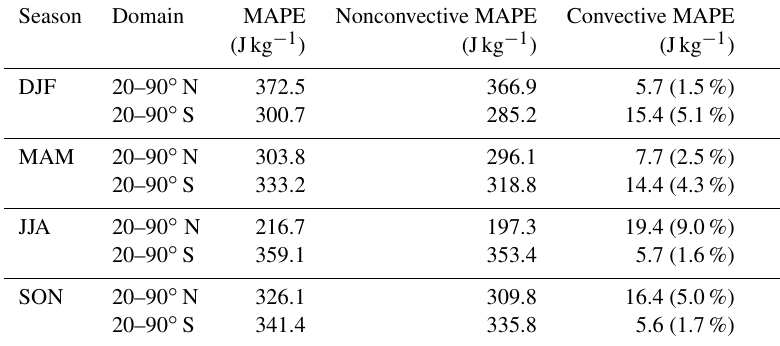
Table 2. Extratropical three-dimensional MAPE, nonconvective MAPE, and convective MAPE in joules per kilogram over 1979–2018. The convective fraction is shown in parentheses as a percentage of full MAPE. Results in this table are based on a lower-resolution horizontal grid with 1800 surface grid cells (a 30 × 30 grid in each hemisphere), and the (full) MAPE values differ slightly from those in Table 1 because of the lower resolution and because divide and conquer is used here rather than integer linear programming in Table